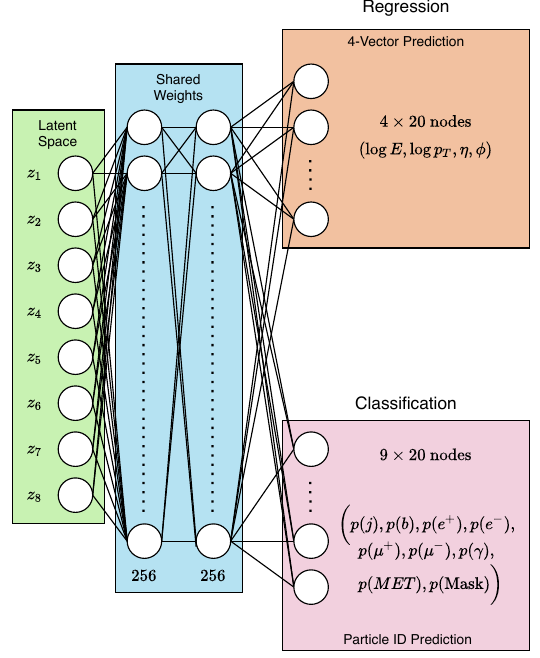
Figure 2: The decoder takes latent space representations of events and outputs a set of par- ticles. The blue box denotes shared wights between the two final output components. The orange box is a set of four-vectors for each of the predicted particles. The pink box represents the classification prediction which assigns a probability to each particle to belong to a certain class or to be masked